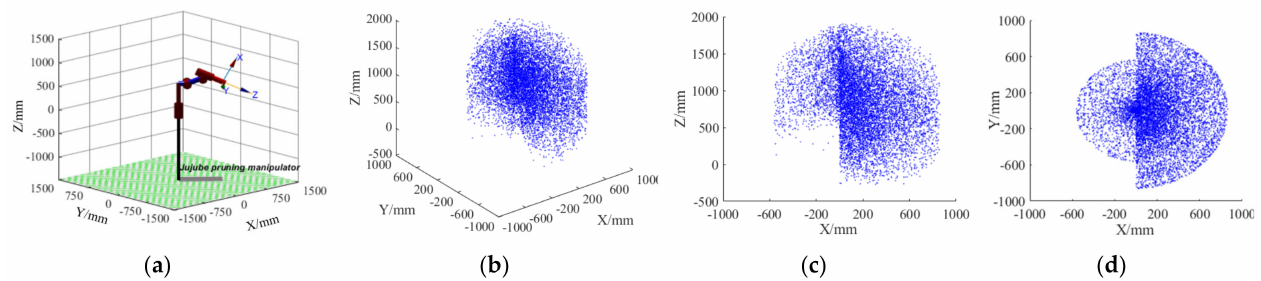
Figure 13. The simulation results of the manipulator workspace. ( a ) The three-dimensional math- ematical simulation model of the manipulator; ( b ) the three-dimensional manipulator workspace; ( c ) the projection of the workspace onto the XOZ plane; and ( d ) The projection of the workspace onto the XOY